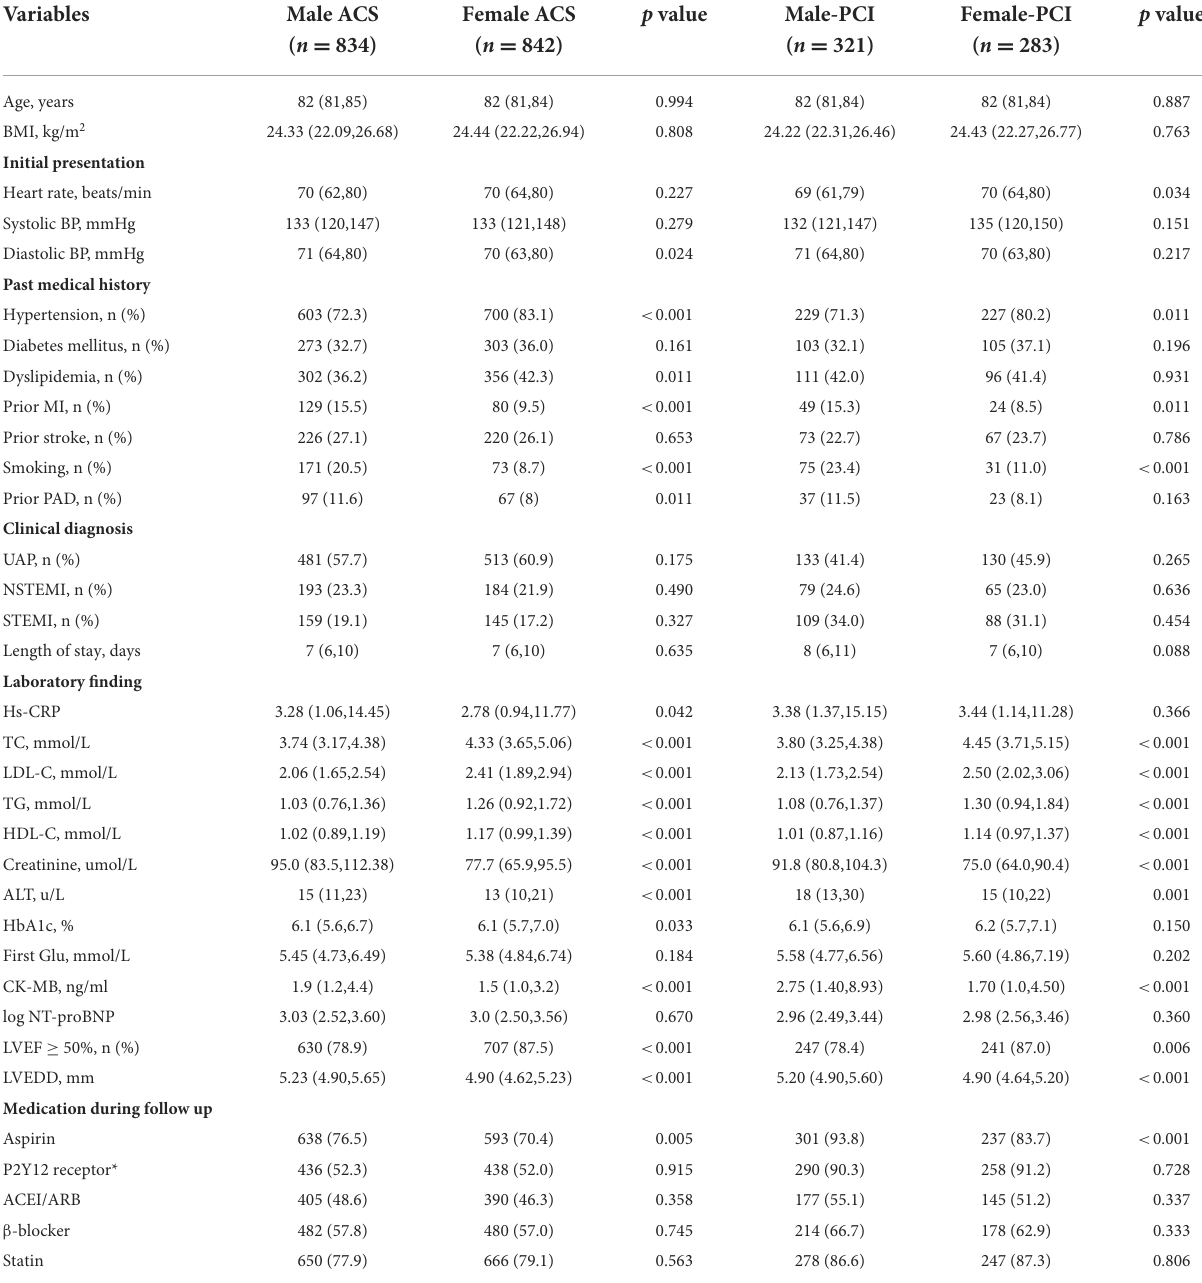
TABLE 1 Baseline clinical characteristics in very elderly ACS